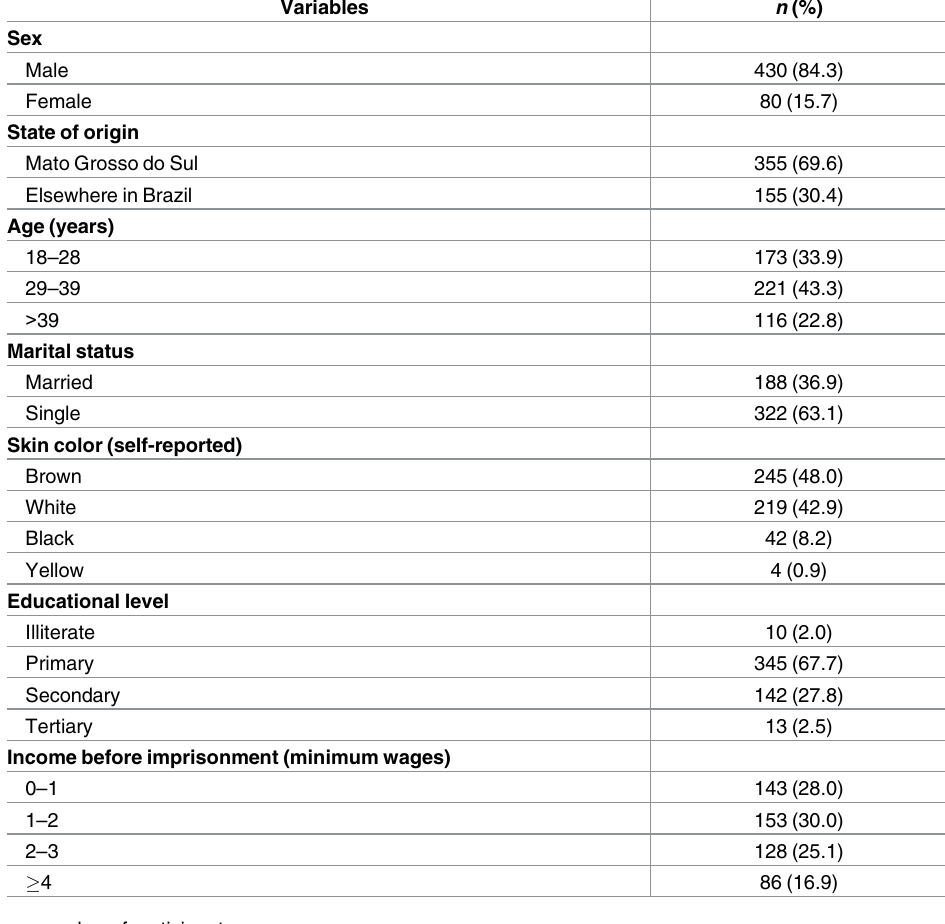
Table 1. Sociodemographic characteristics of inmates serving sentences at three prison facilities in Mato Grosso do Sul, Midwest Brazil ( n =